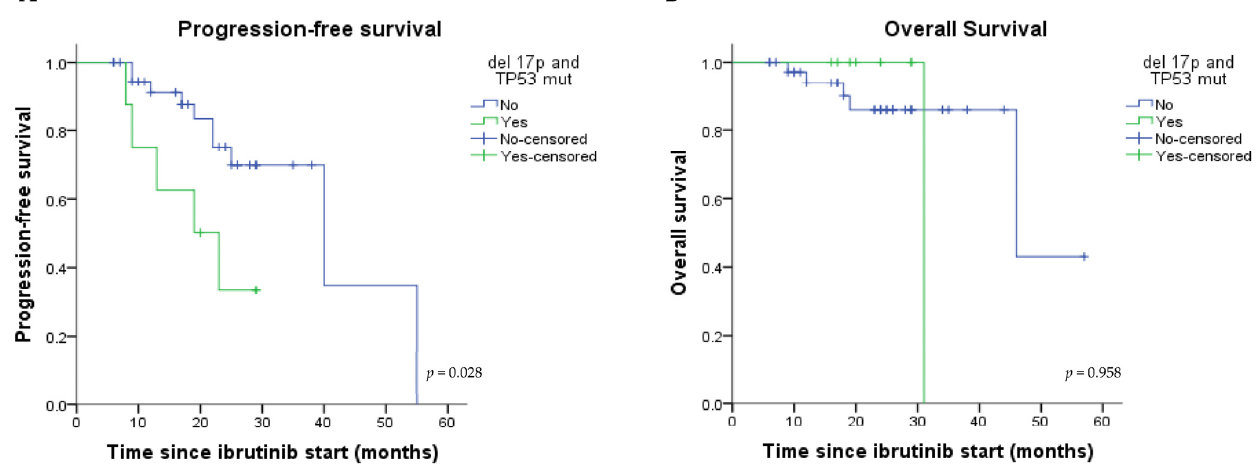
Figure 2. Kaplan–Meier estimated progression-free ( A ) and overall survival ( B ) curves according to the presence/absence of combined del 17p and TP53 mutations. Abbreviations: del 17p, deletion 17p; TP53 mut, TP53 mutations.